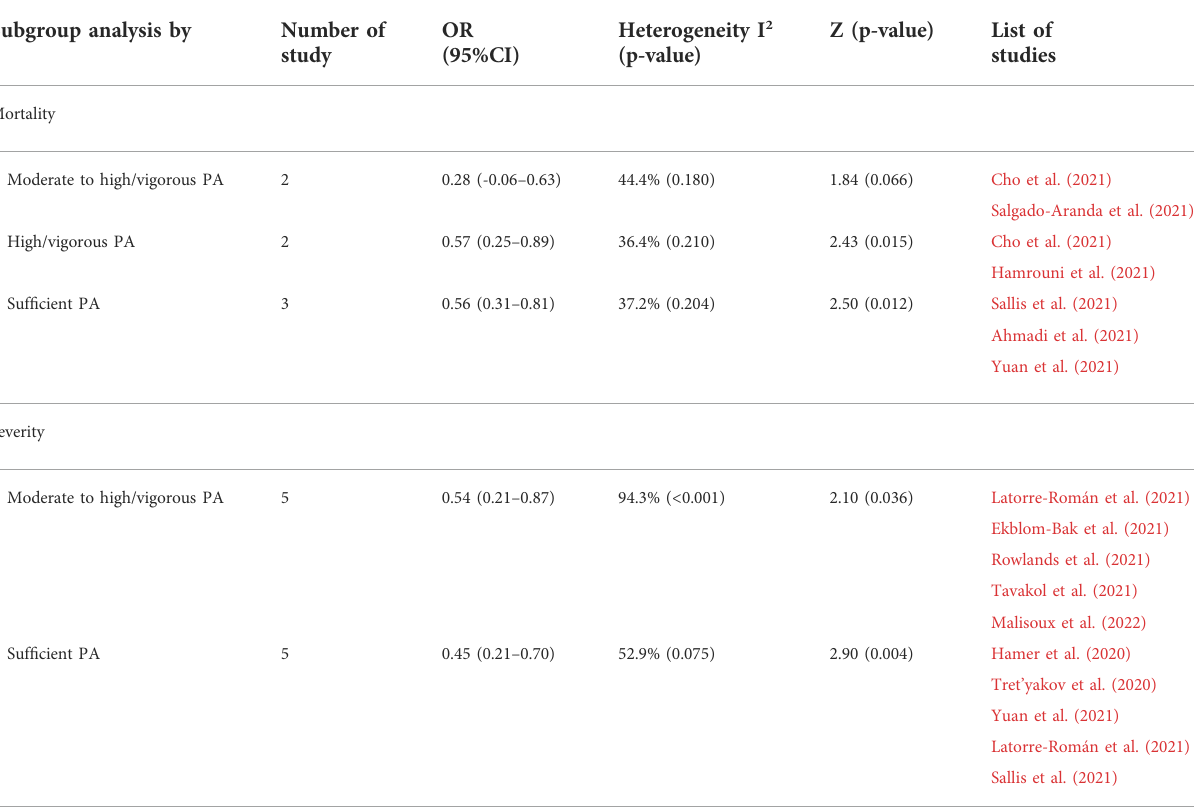
TABLE 4 Subgroup analyses of the included